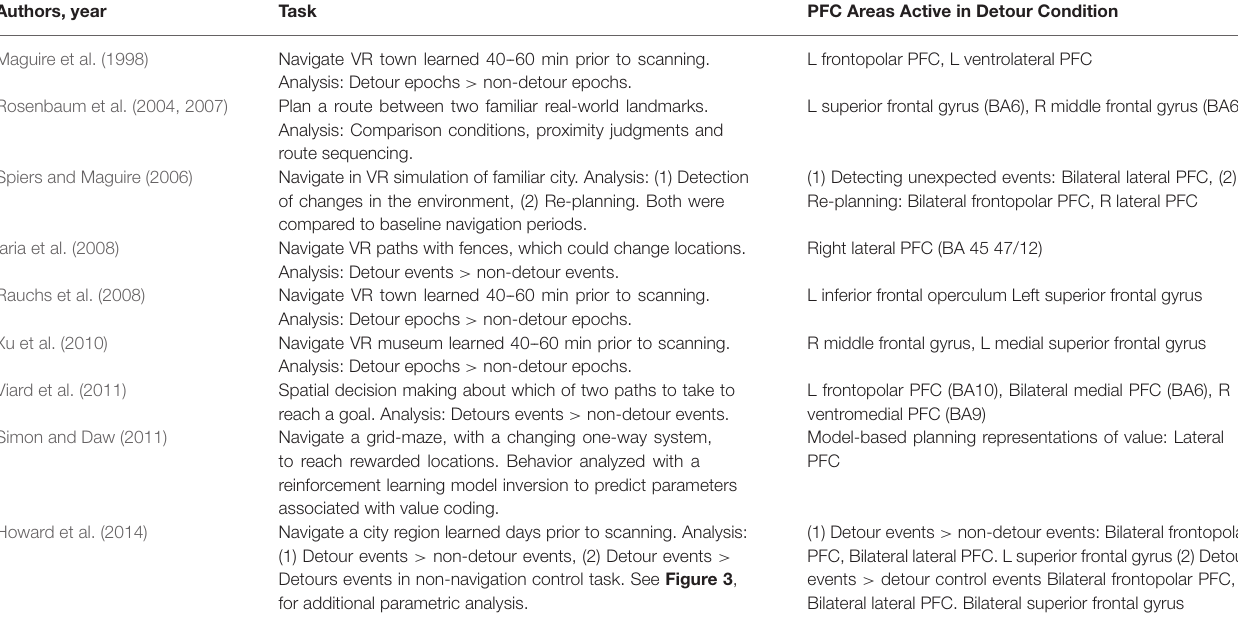
TABLE 1 | Prefrontal cortex activations in studies examining detours in spatial navigation tasks . Authors, year